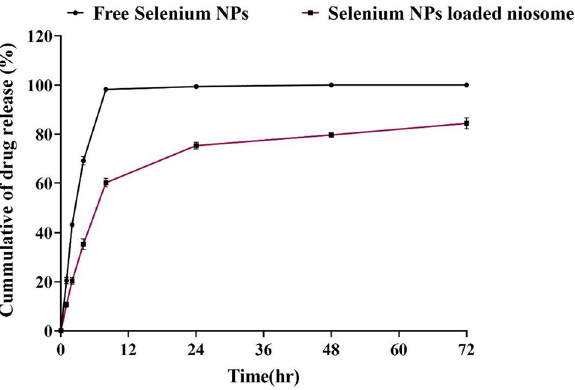
Figure 2. The release profile of SeNPs from noisome-loaded SeNPs at 72 h. SeNPs release from niosomal form has been compared with free